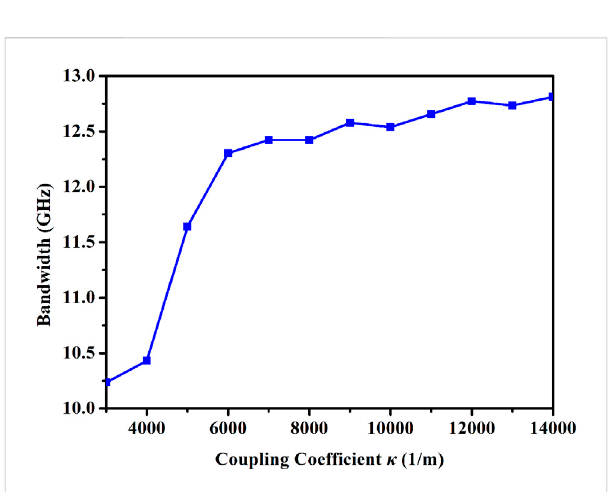
FIGURE 8 Chaotic bandwidth as functions of the DBR grating coupling coef fi cient κ